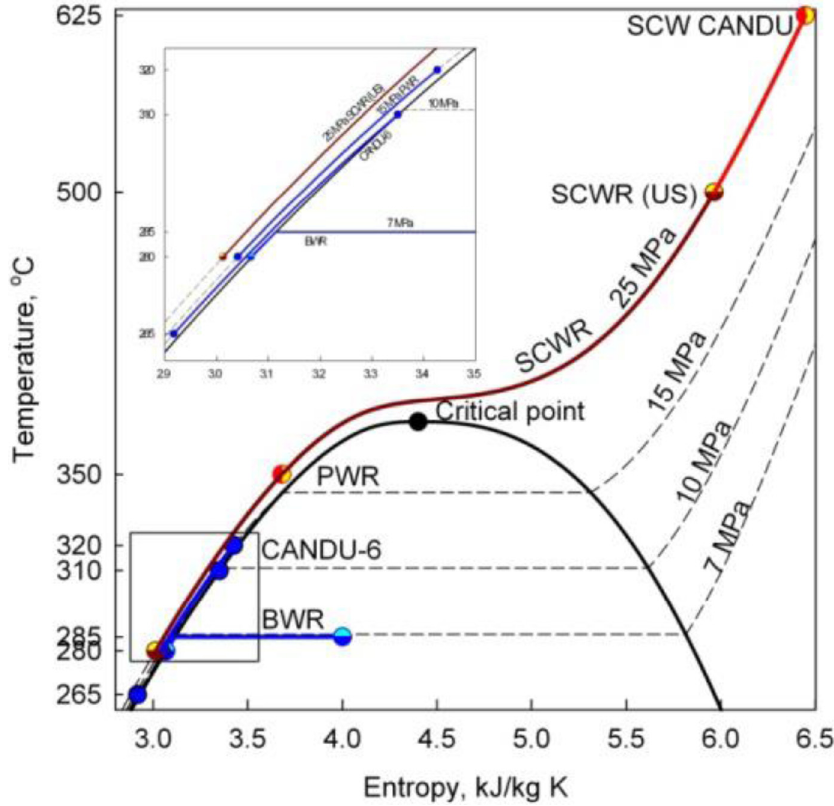
Fig. 1. Operating conditions of current nuclear reactors and SCWRs [1].